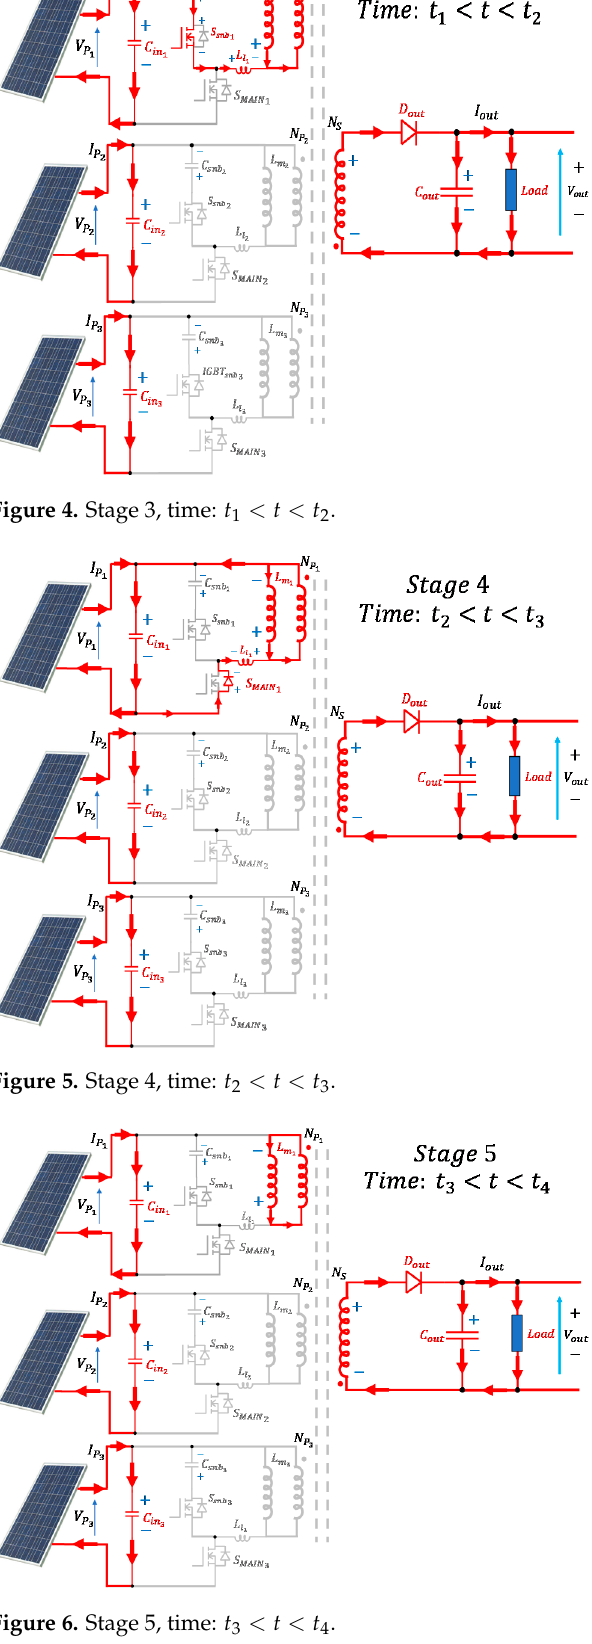
Figure 6. Stage 5, time: t 3 < t < t 4